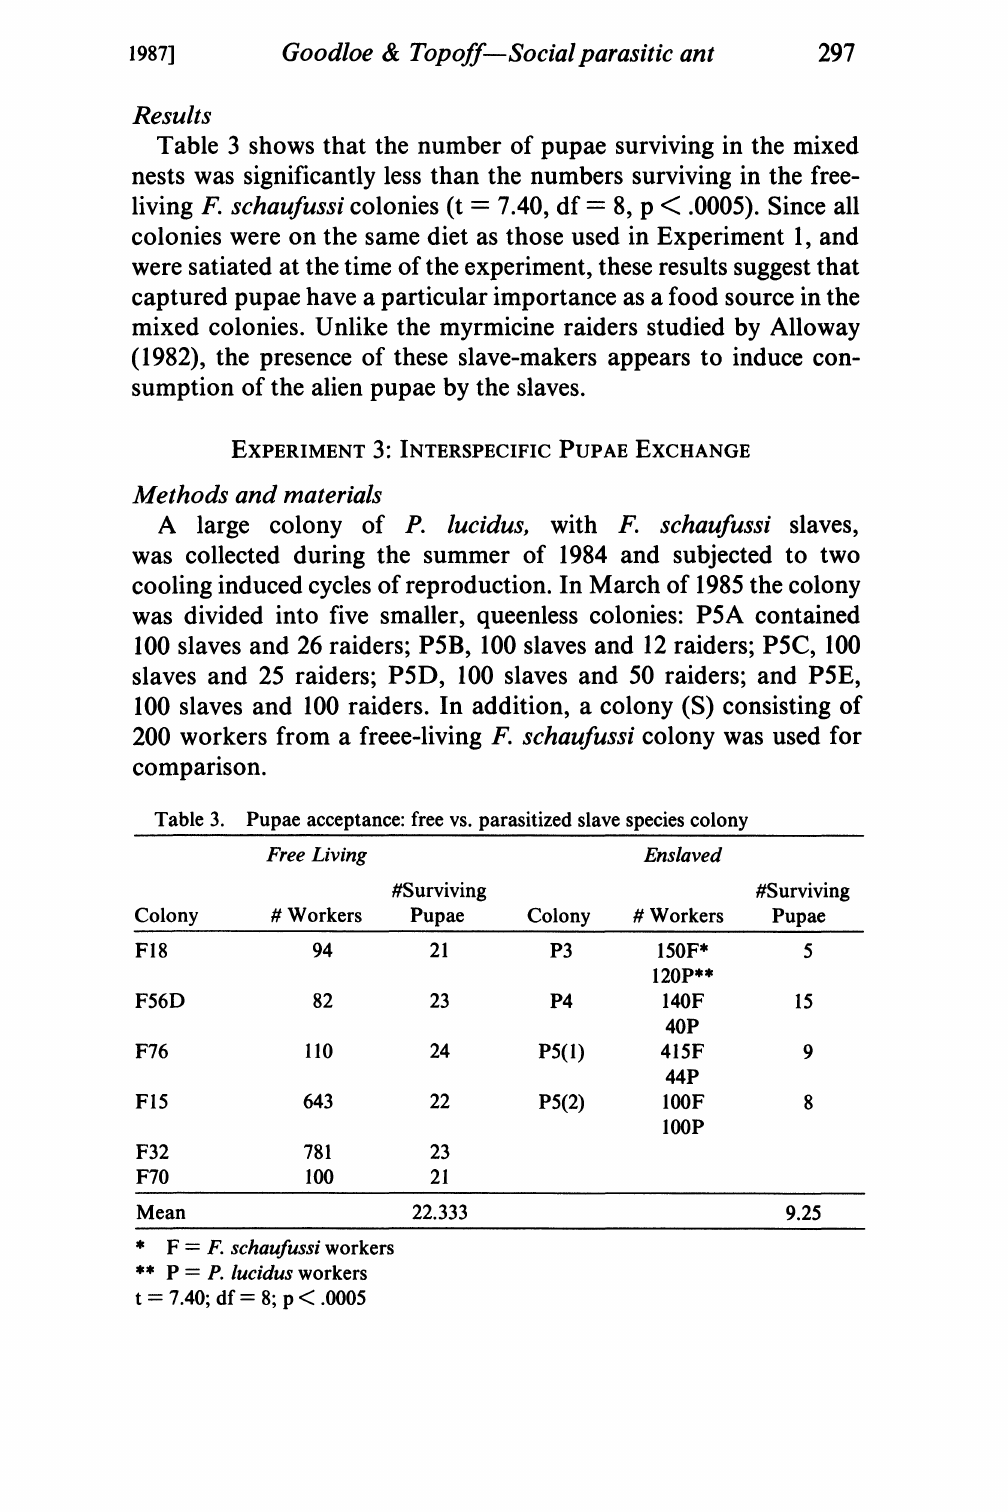
Table 3. Pupae acceptance: free vs. parasitized slave species colony Free Living Enslaved #Surviving #Surviving Colony # Workers Pupae Colony # Workers